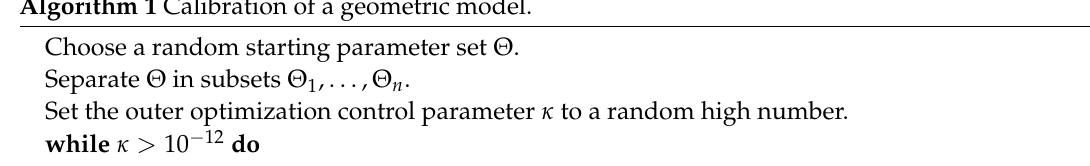
Algorithm 1 Calibration of a geometric